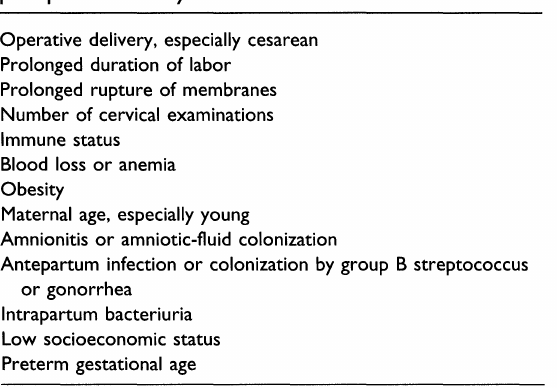
TABLE I. Risk factors for the development of puerperal